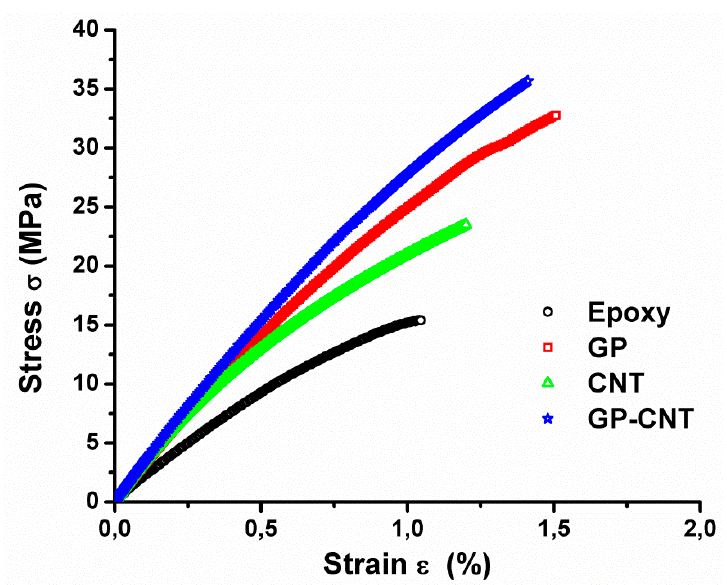
Figure 7. Stress–strain curves and mechanical parameters of epoxy resin with and without carbon nanotubes and GPOSS.